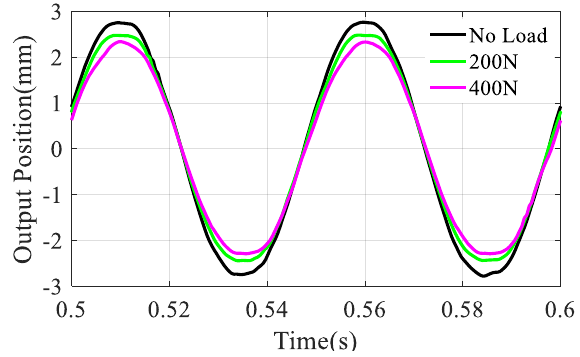
Figure 16. Experimental position outputs under spring forces.